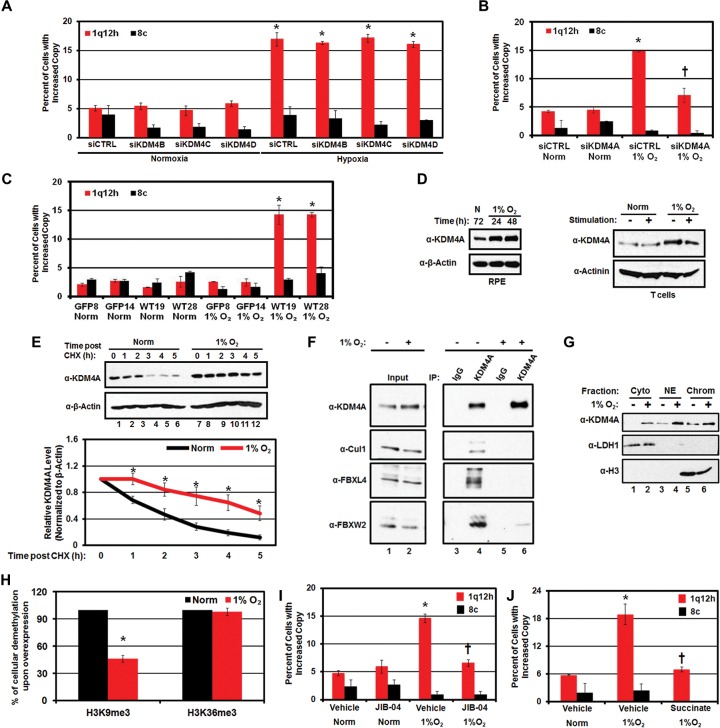
Hypoxia-induced site-specific copy gains are KDM4A-dependent. (A) KDM4B–D are not required for copy gain in hypoxia. Quantification of FISH for 1q12h and 8c in RPE cells depleted of KDM4B, KDM4C, or KDM4D and maintained in normoxia or hypoxia. Data presented are an average of two independent experiments, each performed with two independent siRNAs. (B) Hypoxia-induced 1q12h and 1q21.2 copy gains require KDM4A. Quantification of FISH for 1q12h and 8c in RPE cells after 24 h of normoxia or hypoxia and with or without depletion of KDM4A. Data presented are an average of two independent siRNA. (C) Genomic deletion of KDM4A using CRISPR/Cas9 abrogates hypoxia-driven copy gain. Quantification of FISH for 1q12h and 8c in 293T CRISPR cell lines stably expressing either GFP or GFP-KDM4A following 24 h of normoxia or hypoxia. Data represent an average of two independent experiments for two independently derived single-cell clones of GFP (GFP8 and GFP14) or GFP-KDM4A (WT19 and WT28). (D) Hypoxia stabilizes KDM4A protein levels. Western blot indicates KDM4A protein levels after 24 and 48 h of hypoxic treatment in RPE cells (left panel) and primary human T cells with or without stimulation (right panel). (E) Hypoxia increases the half-life of KDM4A protein in RPE cells. (Top panel) Western blot of half-life experiment demonstrates that KDM4A is stabilized in hypoxia following cycloheximide treatment. (Bottom panel) Graphical representation of KDM4A half-life in RPE cells. Quantification of half-life indicates a half-life of 1 h 49 min ± 3 min in normoxia and 4 h 56 min ± 37 min in hypoxia. (*) Significant difference from normoxia at the same time point by two-tailed Student's t-test. P < 0.05. (F) Hypoxia abrogates the interaction of the SCF complex with KDM4A. KDM4A was immunoprecipitated from RPE cells maintained in normoxia or hypoxia, and the interaction with components of the SCF complex was analyzed by Western blot. (G) KDM4A levels are increased on chromatin during hypoxia (lanes 5,6 , respectively; 1% O2). (Cyto) Cytoplasm; (NE) nuclear extract; (Chrom) chromatin fraction. (H) KDM4A demethylase activity is retained after 24 h in hypoxia. RPE cells expressing 3xHA-WT-KDM4A were maintained in normoxia or hypoxia for 24 h, and H3K9 and H3K36 demethylation was assessed by immunofluorescence. The graph represents an average of two independent experiments, with demethylase activity in hypoxia normalized to activity in normoxia. (I) Demethylase inhibition with JIB-04 blocks hypoxia-dependent copy gain. Quantification of FISH for 1q12h and 8c in RPE cells upon JIB-04 treatment. (J) Hypoxia-dependent copy gains can be suppressed by treatment with 2 mM succinate. In all panels, error bars indicate SEM. (*) Significant difference from normoxia (B,C) and significant difference from vehicle-treated normoxia samples (I,J) by two-tailed Student's t-test. P < 0.05. (†) Significant difference from siCTRL (1% O2; B) and significant difference from vehicle (1% O2; I,J) by two-tailed Student's t-test. P < 0.05.